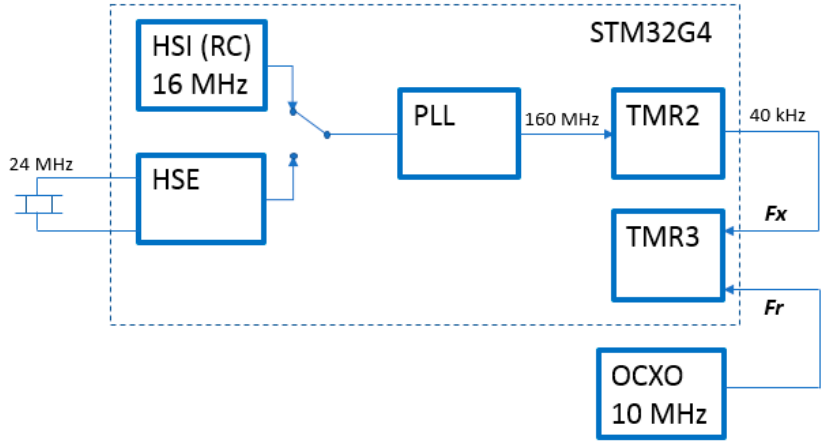
Figure 4. Frequency measurement verification setup.